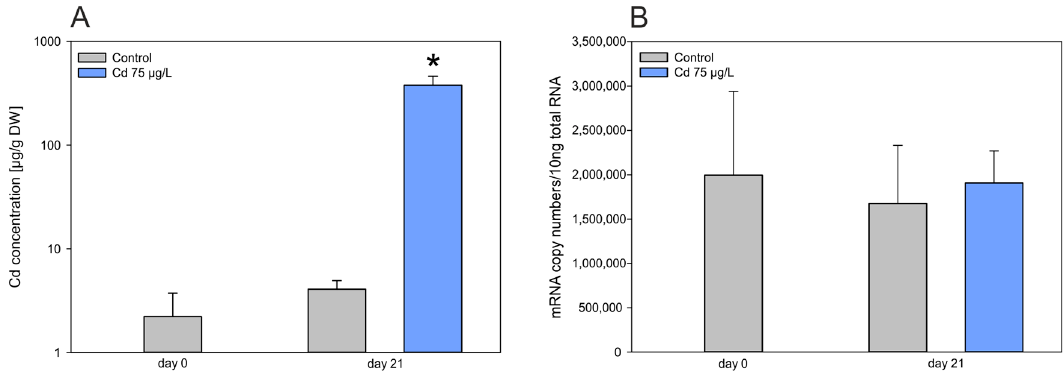
Figure 7. Cd concentration in midgut gland tissue and qRT-PCR of mRNA after Cd exposure. ( A ) Cd concentration in midgut gland tissue of Biomphalaria glabrata on days 0 and day 21 of Cd exposure (75 µg/L); (* p < 0.001); the y-axis shows values in decadic logarithm; ( B ) Quantitative Real-Time PCR data of BgwtMT gene transcription on days 0 and 21 of Cd exposure (75 µg/L). Grey bars: control values; Blue bars: Cd exposure values.